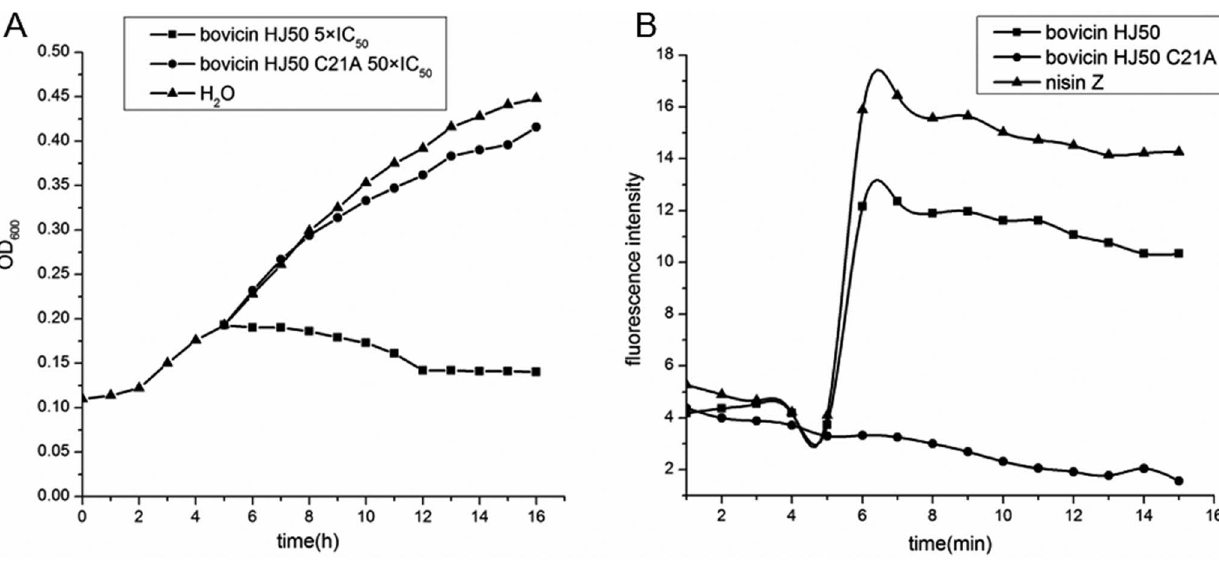
Figure 6. Inhibition of bacterial growth and disruption of membrane by bovicin HJ50. (A) Influence of bovicin HJ50 and its mutant C21A on bacterial growth. The growth curve of M. flavus NCIB8166 was recorded when bovicin HJ50 of 5 6 IC 50 (square dotted curve), its mutant C21A of 50 6 IC 50 (circle dotted curve) and H 2 O (triangle dotted curve) was added at the time point of 5 h. (B) Influence of membrane potential when bovicin HJ50 and its mutant C21A were added to M. flavus NCIB8166. The fluorescence intensity was monitored in a time duration of 15 min. bovicin HJ50 (square dotted curve) and its mutant C21A (circle dotted curve) was added at the time point of 5 min. Nisin Z (triangle dotted curve) was used as positive control.